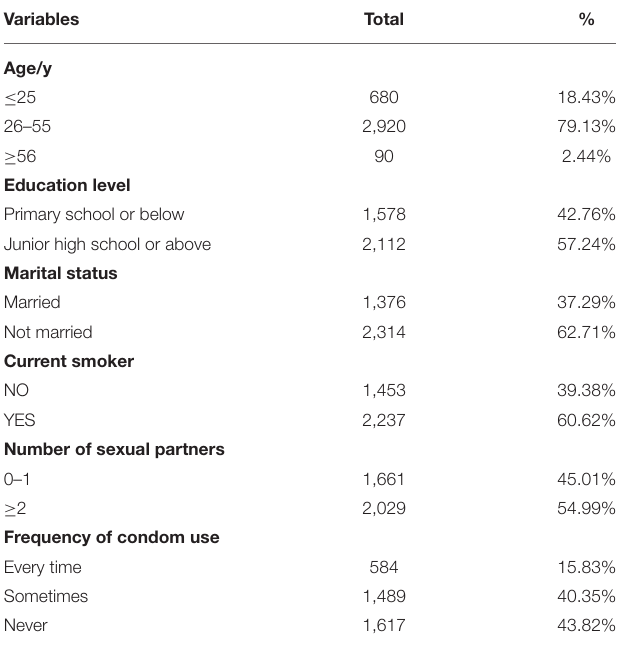
TABLE 1 | Sociodemographic and behavioral characteristics in 3,690 Men.